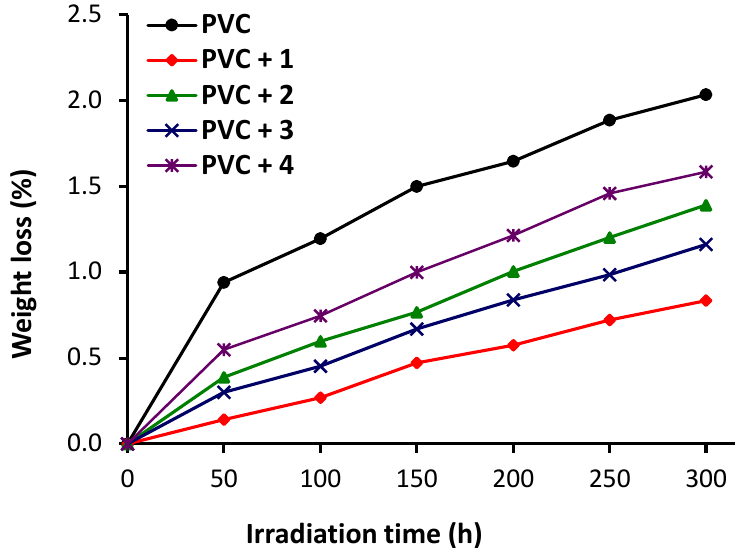
Figure 5. Changes in weight loss (%) for PVC films.